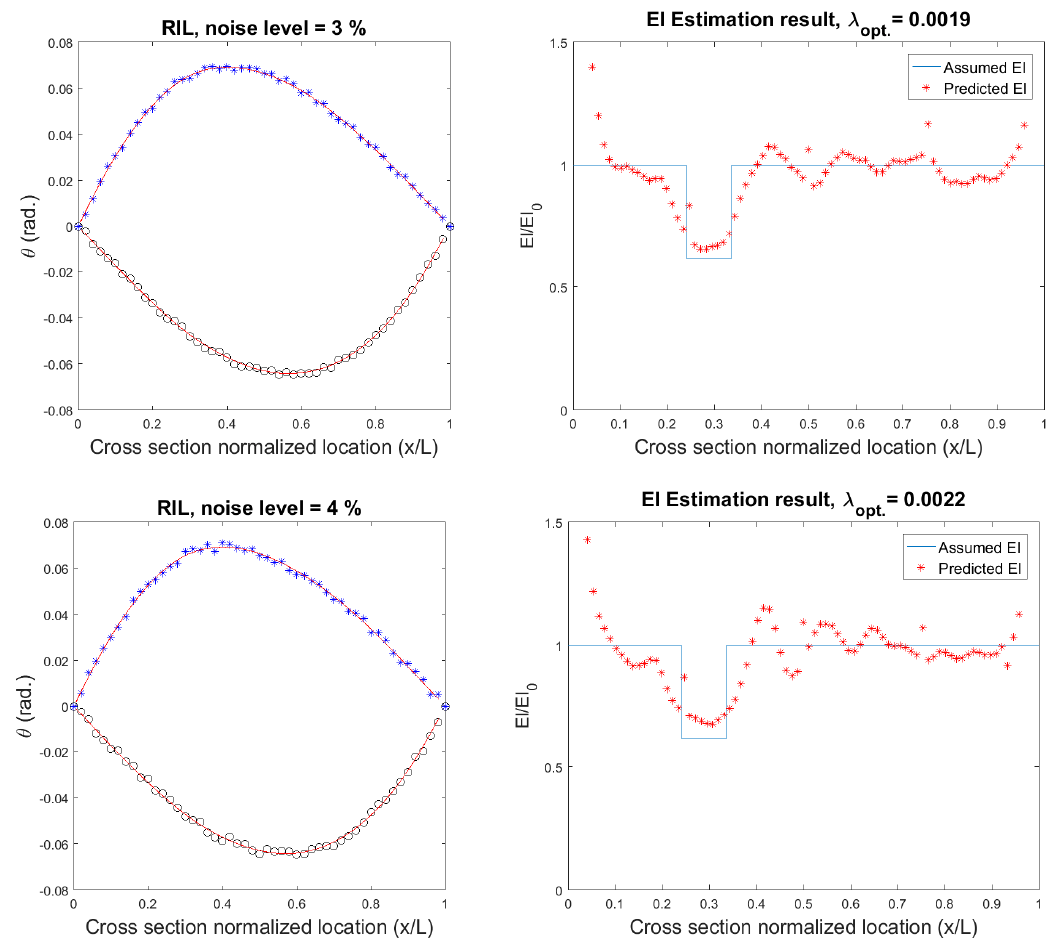
Figure 9. Results of application of the proposed method on a simply supported beam with polluted RILs.